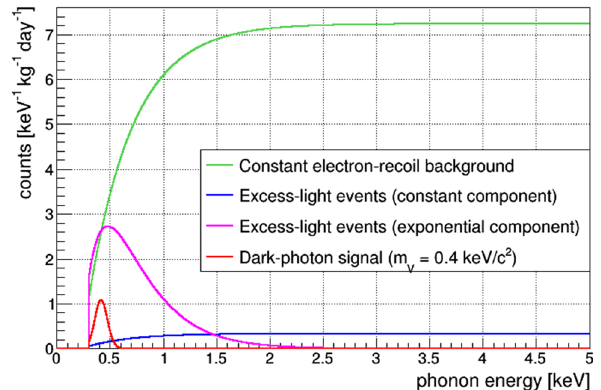
Fig. 3 The PDFs p p , i ( E p | M , θ ) of all model components scaled by the respective rates obtained by the fit of the model to the data (compare Sect.